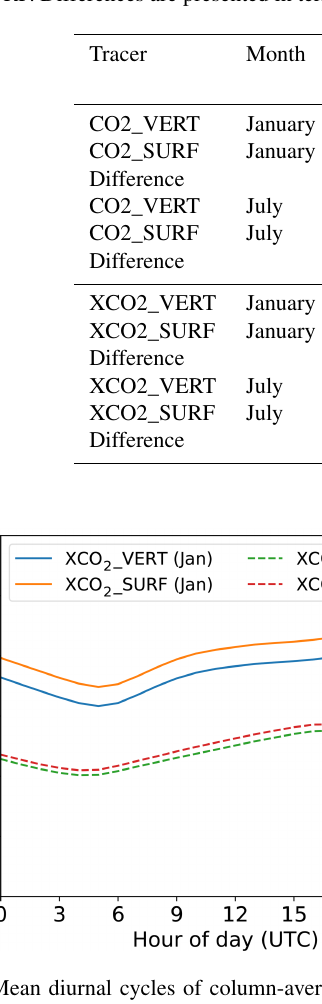
Table 4. Statistics of near-surface CO 2 and column-averaged dry air mole XCO 2 fractions in the model domain for the tracers CO2_VERT and CO2_SURF. Differences are presented in terms of (CO2_SURF-CO2_VERT)/CO2_VERT.